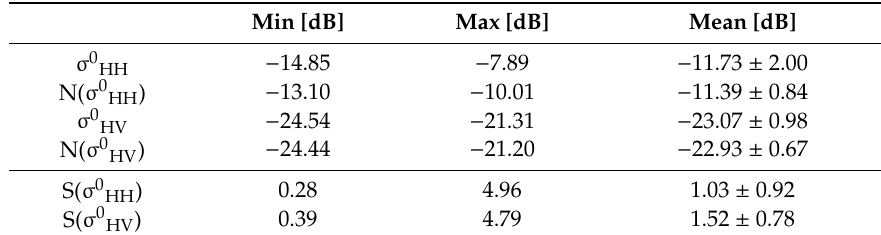
Table 1. Minimum, maximum, mean, and standard deviation of the un-normalized ( σ 0 HH ), normalized (N( σ 0 HH )) backscattering coe ffi cients and spatial standard deviations (S( σ 0 HH )) in a 1 km by 1 km region of interest in HH- and HV-polarization.